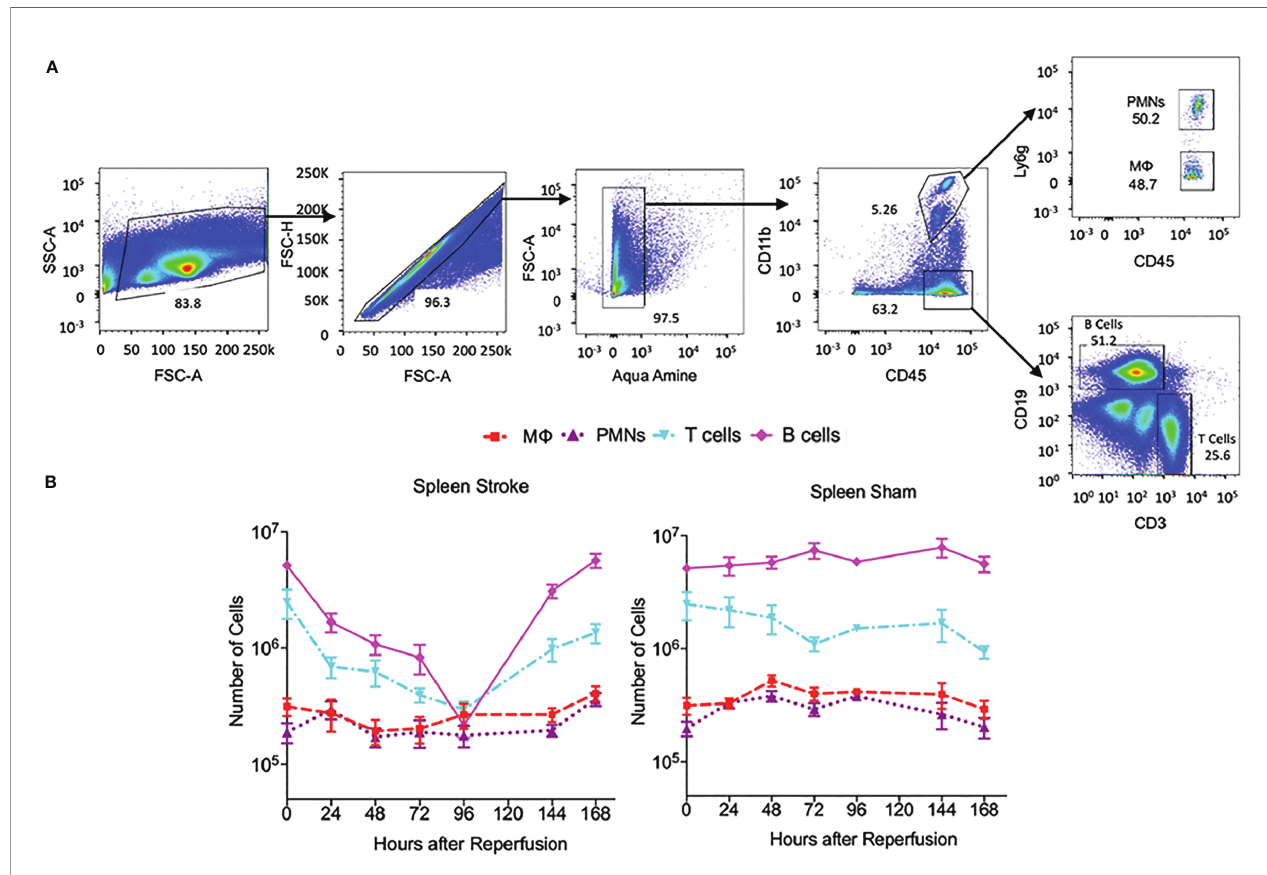
FIGURE 5 | The dynamics of immune cells at the spleen post stroke and sham. (A) Flow cytometry plots showing the gate strategy for identi fi cation of neutrophil (PMNs), macrophage (M Ф ), T cells and B cells. In brief, alive single cells from spleen were chosen for analysis on multiple biomarkers expression level. In particular, neutrophils were identi fi ed as CD45 + CD11b hi Ly6G + , macrophage as CD45 + CD11b hi Ly6G ,T cells as CD45 + CD11b-CD3 + CD19-and B cells as CD45 + CD11b- CD3 + CD19-. (B) A log-scale fi gure shows the number of various immune cells present in spleen until 7 days post stroke. N=7-14 were used across the 7 days of analysis post stroke or sham.